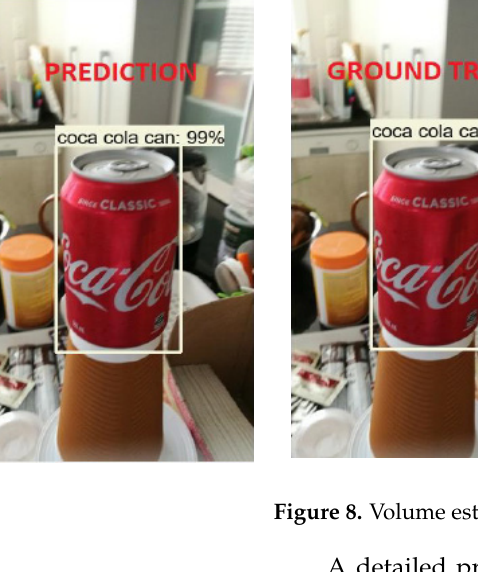
Figure 8. Volume estimation of a Coca-Cola can.